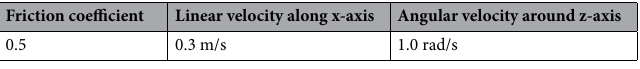
Table 1. Motion model test parameters.